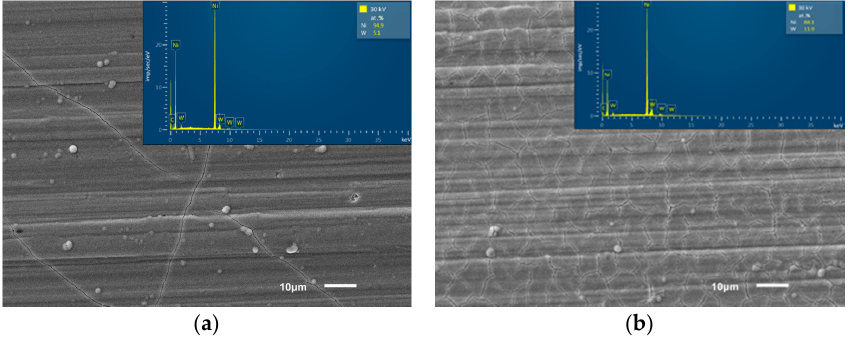
Figure 1. SEM images of Ni–W coatings produced in the DC mode with different current densities, A·cm − 2 : ( a ) 10 − 2 , ( b ) 5 × 10 − 2 . The inset box in the upper right corner in both panels shows the EDS spectra.